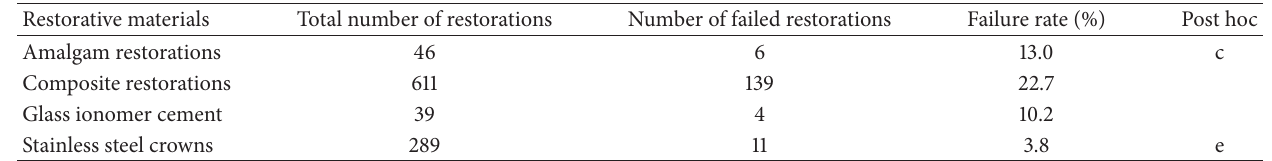
Table 2: Failures rates of different restorative procedures.